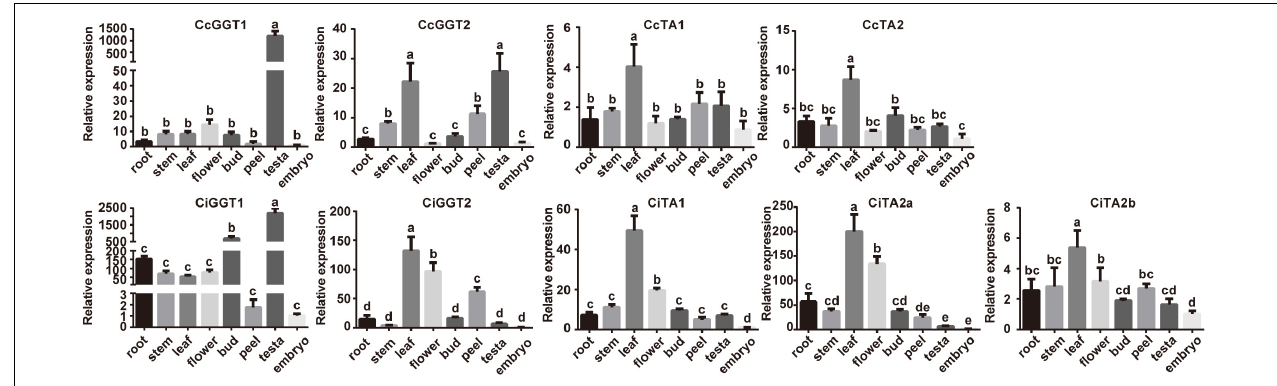
FIGURE 6 | Expression analysis of GGT and TA genes in different tissues in Chinese hickory and pecan by RT-qPCR. The analysis was carried out using three biological replicates and three technical replicates for each sample. The error bars represented the standard deviations of nine replicates. Different letters indicated significant differences according to the Tukey–Kramer test ( P <